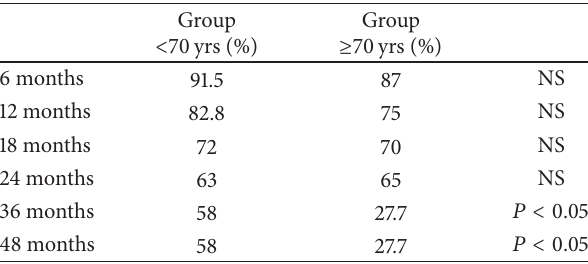
Table 5: Survival rates between the two